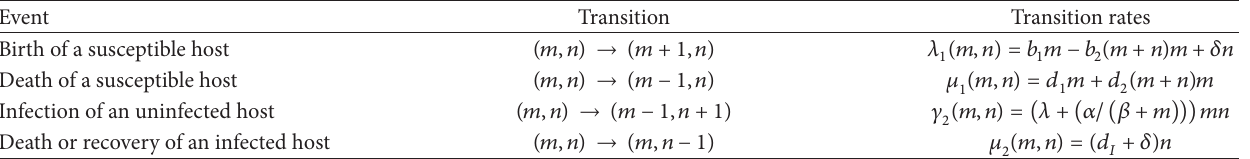
Table 1: Hypothesized transition rates for the stochastic